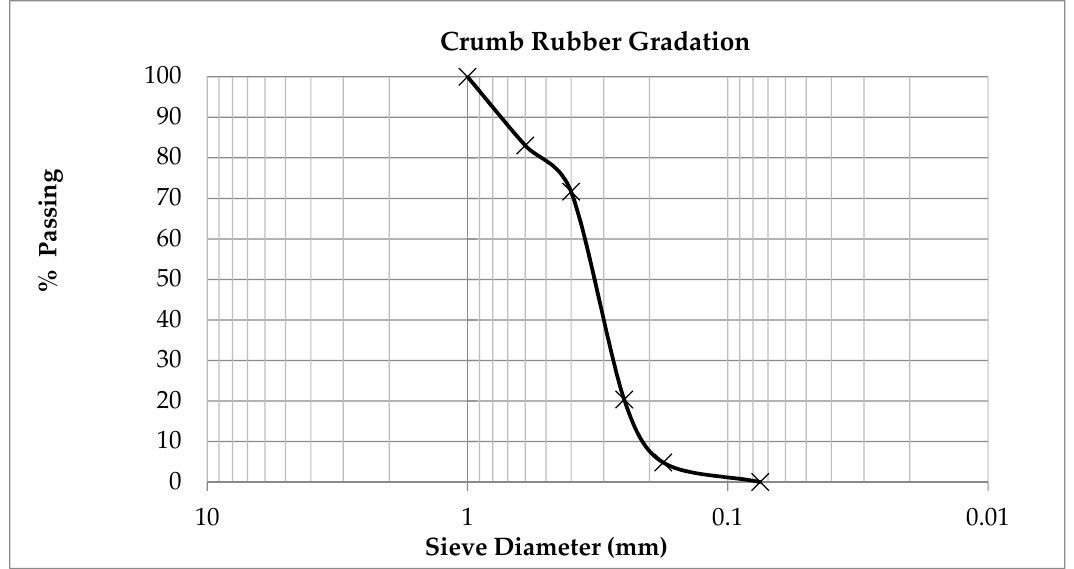
Figure 1. Gradation of the crumb rubber modifier (CRM) used.